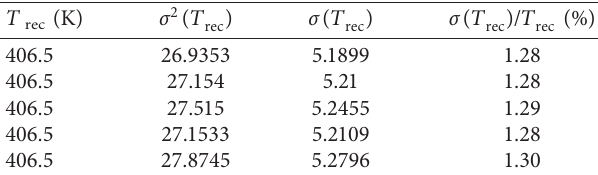
Table 5: Accuracy calculation results of the ambient and hot load method.